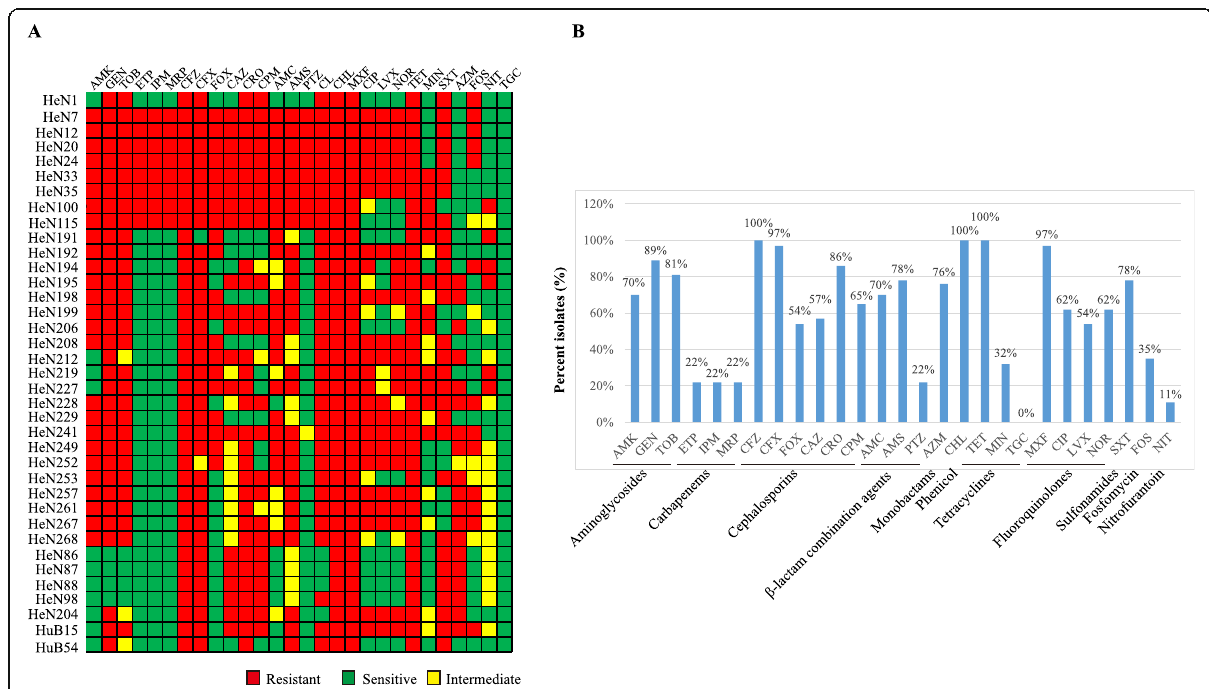
Fig. 2 Antimicrobial resistance phenotypes of mcr -positive E. coli isolates. A Heat map showing antimicrobial resistance patterns of mcr -positive isolates in response to 28 test antibiotics. Small boxes marked in red, green and yellow represent resistant, sensitive and intermediate phenotypes. Results were interpreted according to the CLSI breakpoints (CLSI M100, 28th Edition). If a CLSI breakpoint was not available, an EUCAST breakpoint was used. B Column chart showing the percentages of isolates displaying phenotypes resistant to different tested antibiotics. AMK: amikacin, GEN: gentamicin, TOB: tobramycin, ETP: ertapenem, IPM: imipenem, MRP: meropenem, CFZ: cefazolin, CFX: cefuroxime, FOX: cefoxitin, CAZ: ceftazidime, CRO: ceftriaxone, CPM: cefepime, AMC: amoxicillin/ clavulanate, AMS: ampicillin/sulbactam, PTZ: piperacillin/tazobactam, CL: colistin, AZM: aztreonam, CHL: chloramphenicol, TET: tetracycline, MIN: minocycline, TGC: tigecycline, MXF: moxifloxacin, CIP: ciprofloxacin, LVX: levofloxacin, NOR: norfloxacin, SXT: trimethoprim/sulfamethoxazole, FOS: fosfomycin, NIT: